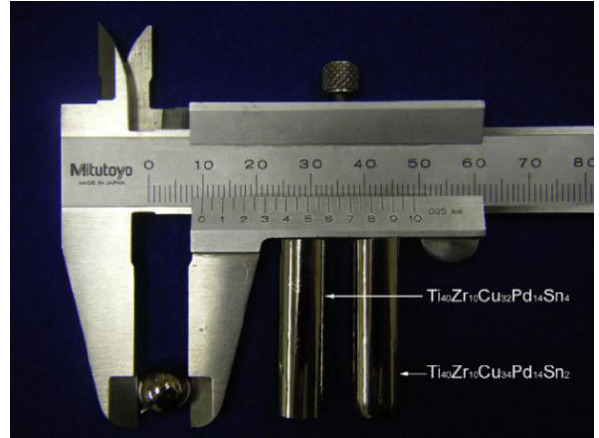
Figure 5. Outer surface of cast Ti 40 Zr 10 Cu 34 Pd 34 Sn 2 and Ti 40 Zr 10 Cu 32 Pd 14 Sn 4 BMG rods with a diameter of 10 mm. Reproduced with permission from [47]. Copyright 2008, Elsevier.